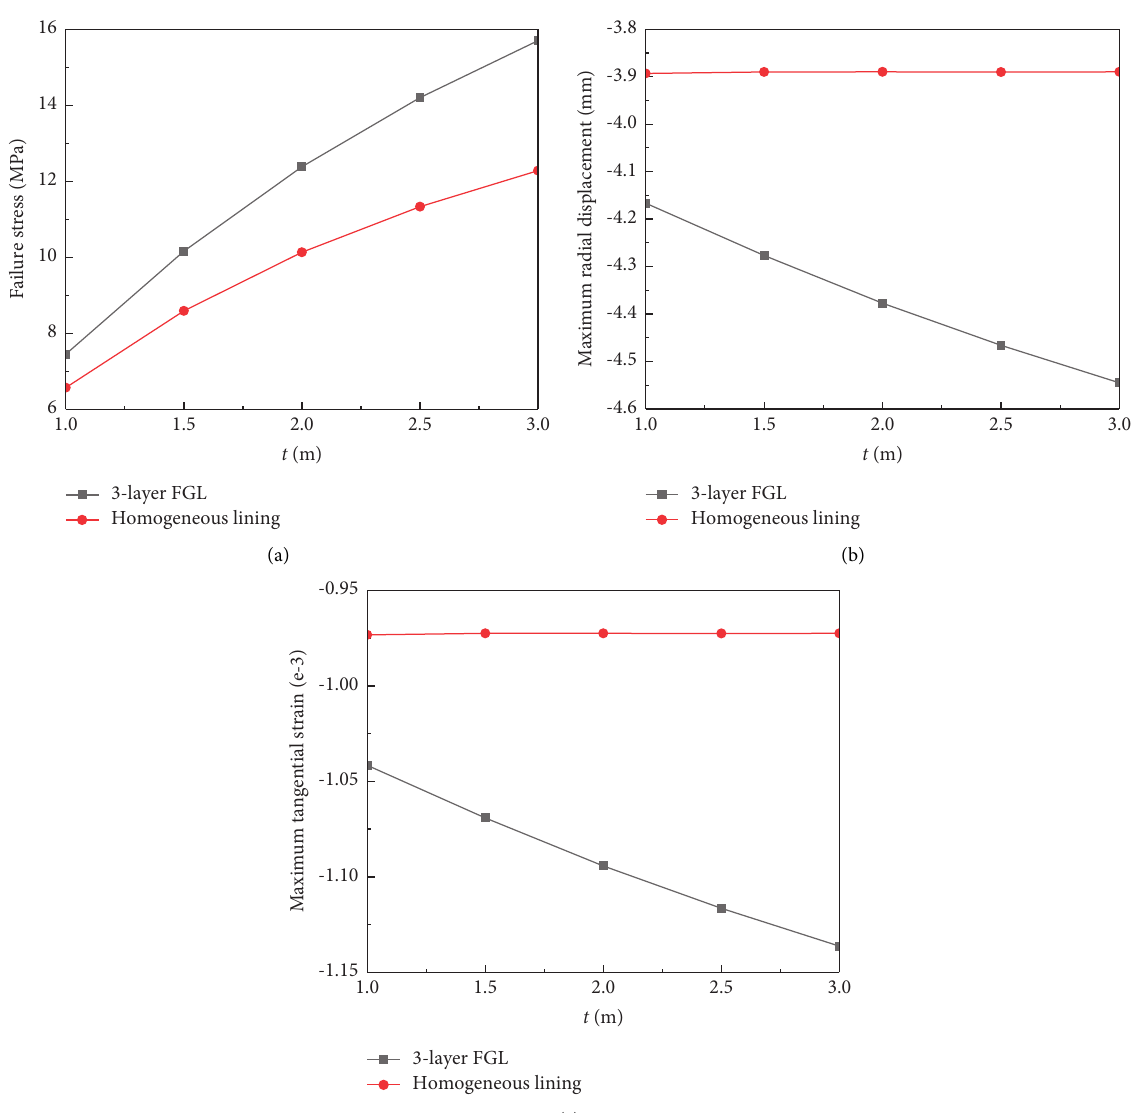
Figure 11: Variations in ultimate bearing capacity, maximum radial displacement, and maximum tangential strain with thickness t . (a) Ultimate bearing capacity. (b) Maximum radial displacement. (c) Maximum tangential